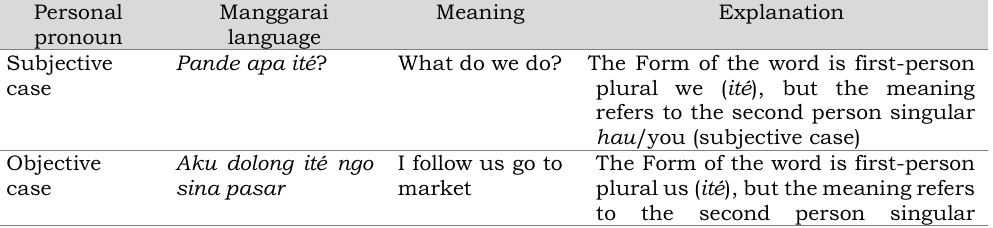
Table 7. The use of ité in the second person